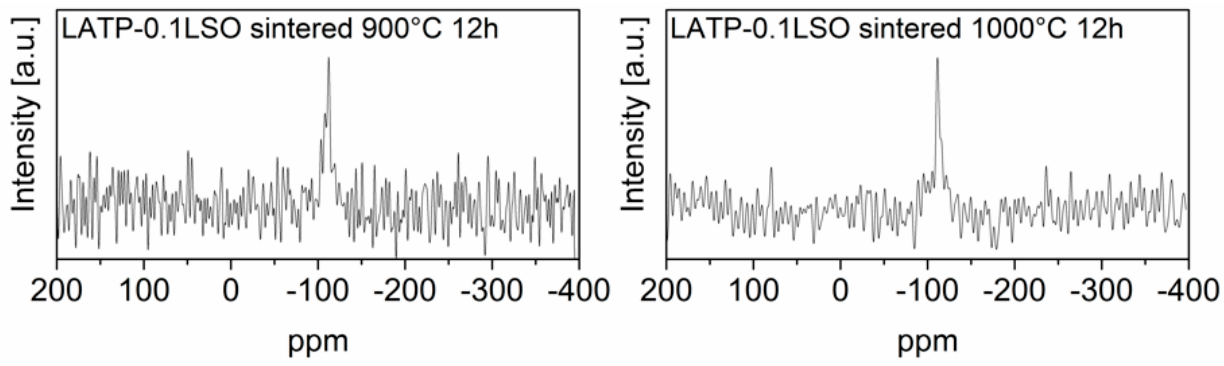
Figure 7. 29 Si MAS NMR spectra of LATP-0.1LSO sintered at 900 ◦ C or 1000 ◦ C for 12 h. The experimental spectra are displayed as black lines.